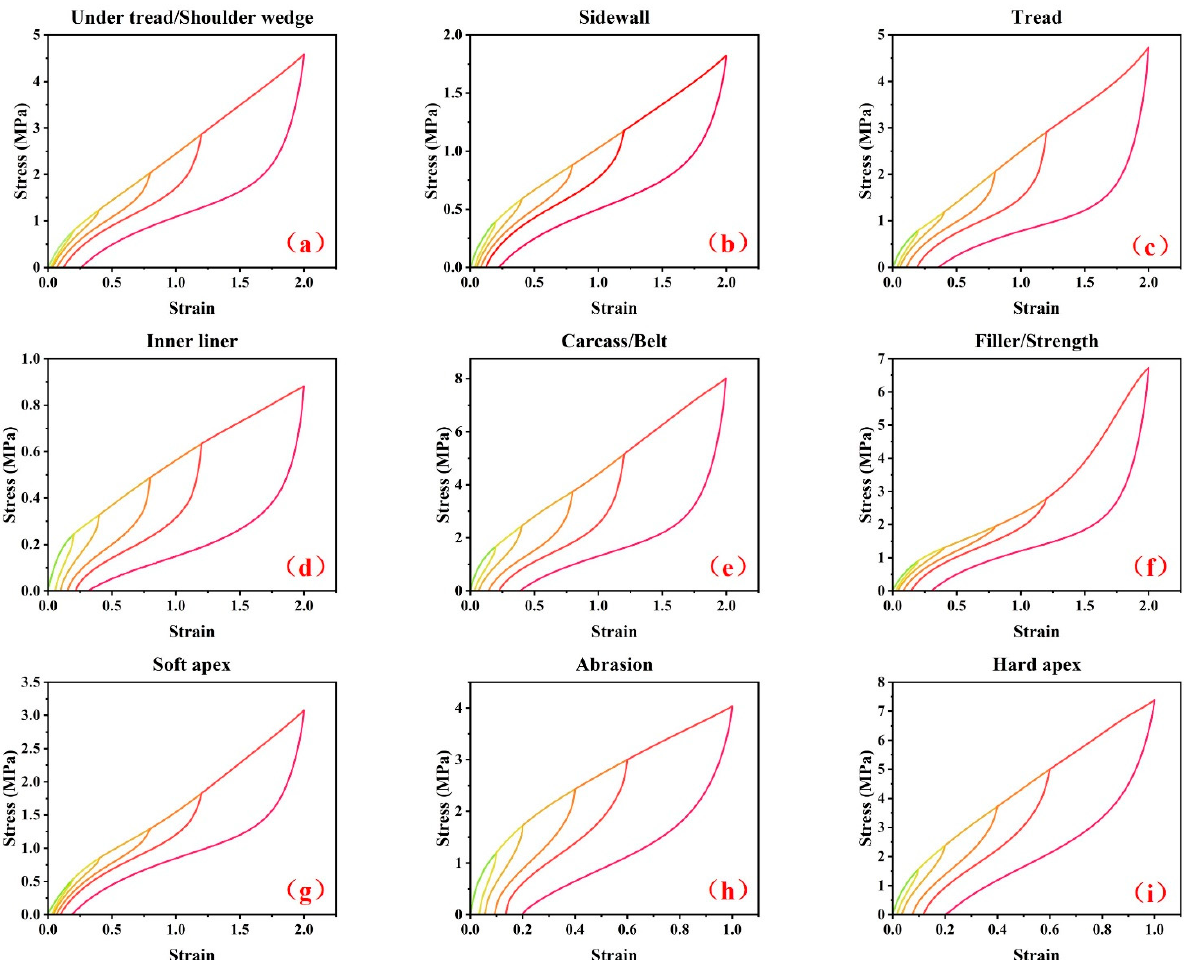
Figure 5. The adjusted stress–strain curves for nine different rubber specimens from TBR tire. ( a ) under tread and shoulder wedge, ( b ) sidewall, ( c ) tread, ( d ) inner liner, ( e ) carcass rubber and belt rubber, ( f ) filler rubber and strength rubber, ( g ) soft apex, ( h ) abrasion and ( i ) hard apex.